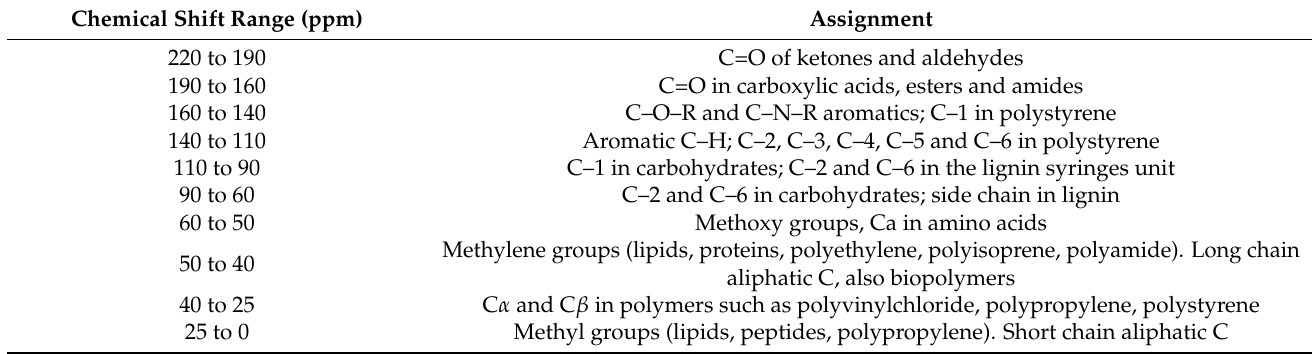
Table 1. Chemical shift regions of 13 C–{ 1 H} NMR spectra of OFMSW [29,30]. Chemical Shift Range